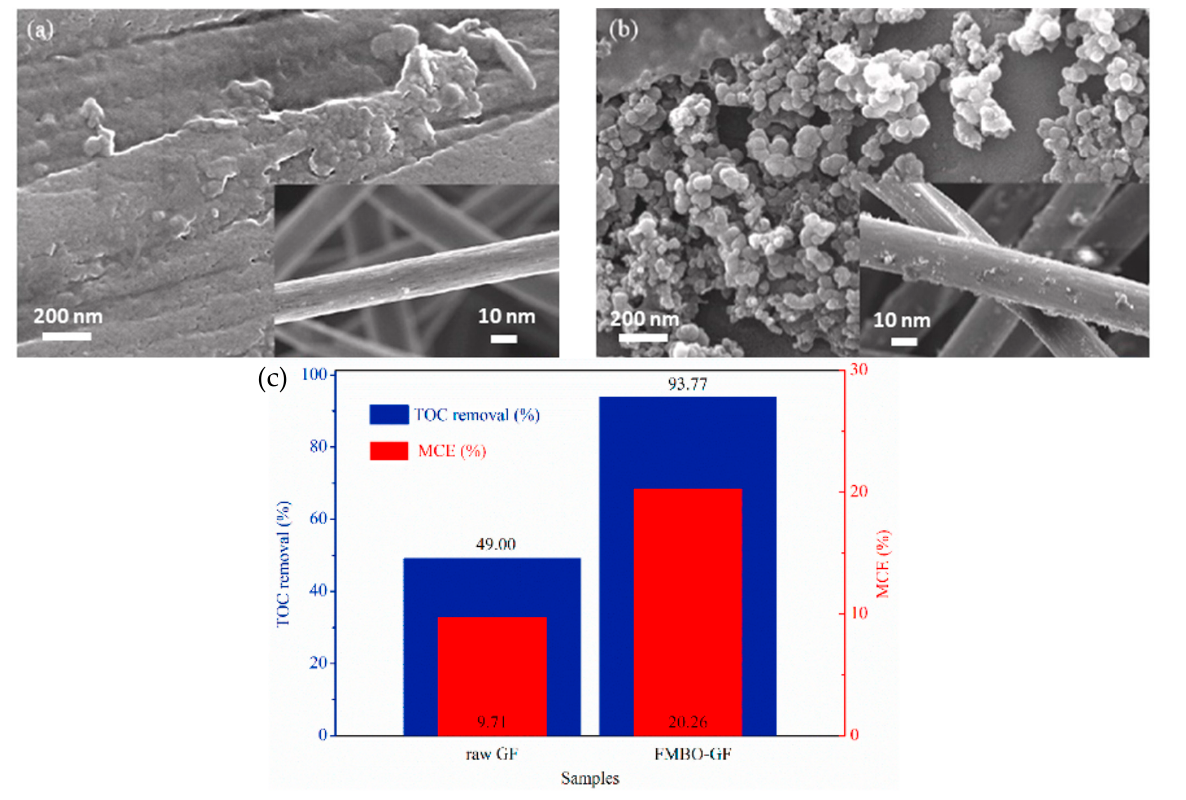
Figure 7. SEM images of ( a ) the unmodified graphite felt (raw GF) cathode, ( b ) the unmodified graphite felt (FMBO–GF) cathode, and ( c ) TOC removal efficiency and the mineralization current efficiency (MCE) of raw GF and FMBO–GF in 2 h under 25 mg/L initial pollutant concentration, pH 7, and 2 mA/cm 2 current density [155].